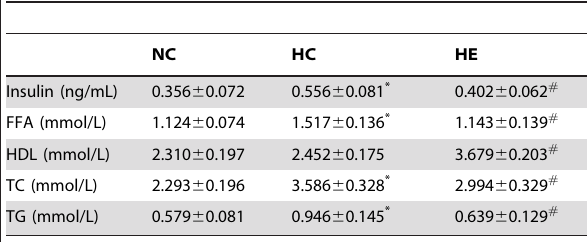
Table 1. Insulin level and plasma lipid parameters after 6- week aerobic exercise.